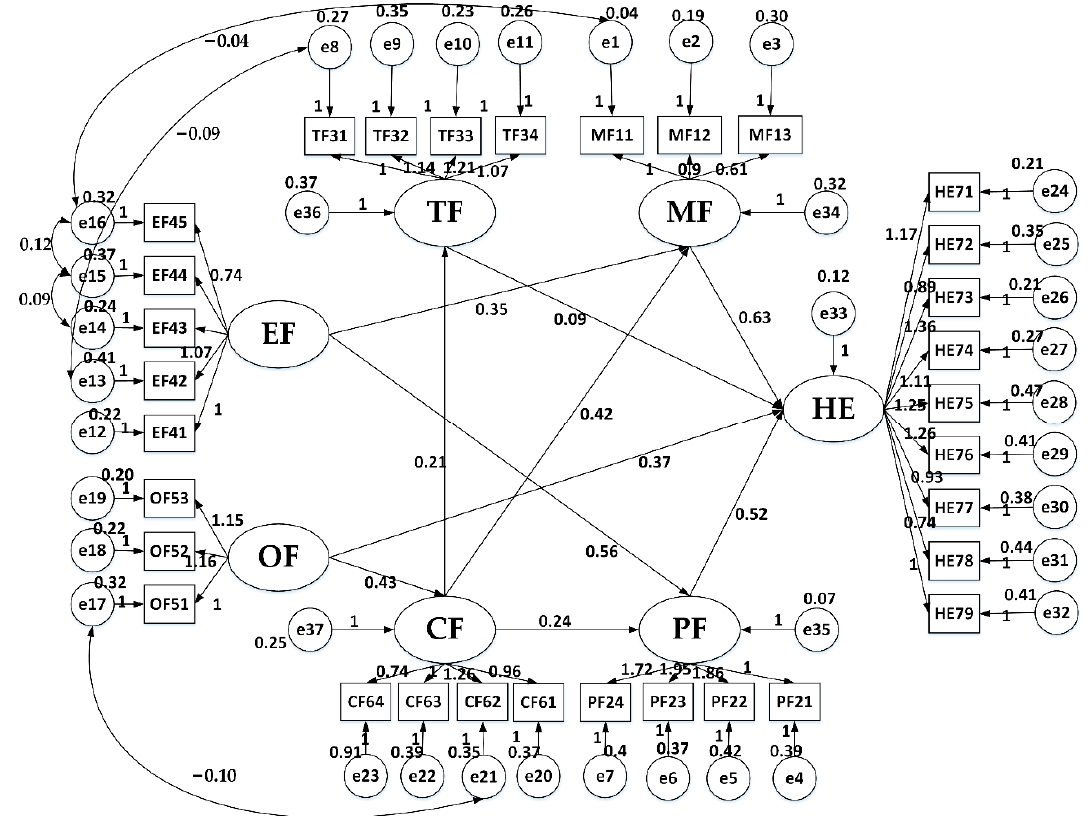
Figure 3. The operation result of optimal structural equation model.